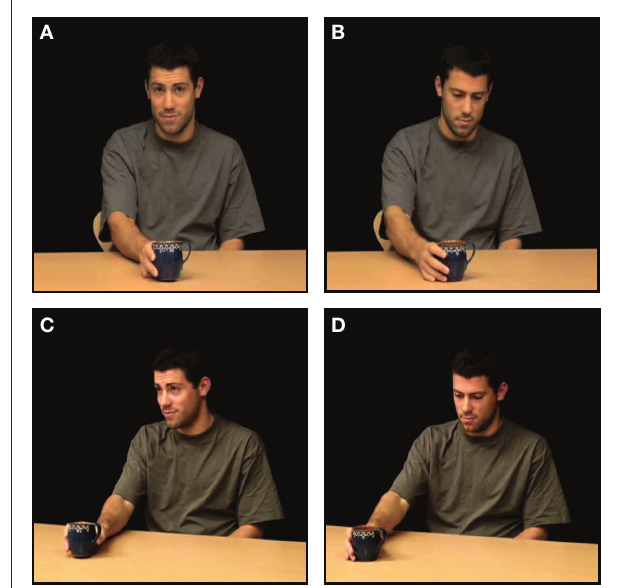
FIGURE 1 | Example of stimuli. In 5s video clips, an actor performed simple object gestures (“ placing an object for” or “ showing an object to ” someone) in four conditions: (A) ostensive and direct, (B) non-ostensive and direct, (C) ostensive and averted, (D) non-ostensive and averted. Besides, all four conditions were replicated without the object